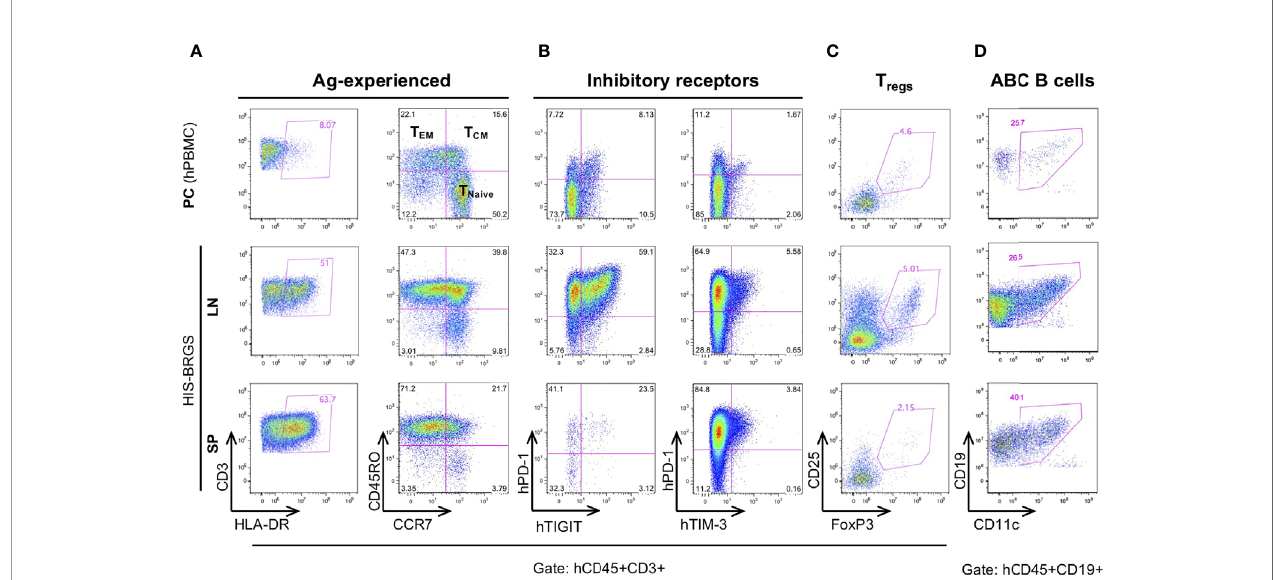
FIGURE 3 | Immunostimulatory and immunomodulating human lymphocyte subsets in the lymph nodes (LN) and spleen (SP) of HIS-BRGS mice. T cell expression of (A) activation marker, HLA-DR, and memory cell markers, CD45RO/CCR7, (B) inhibitory receptors, PD-1, TIGIT, TIM-3, and (C) regulatory T cell markers, CD25 + FoxP3 + . (D) CD11c + B cells. Human PBMC served as a technical staining control ( “ PC ” , top